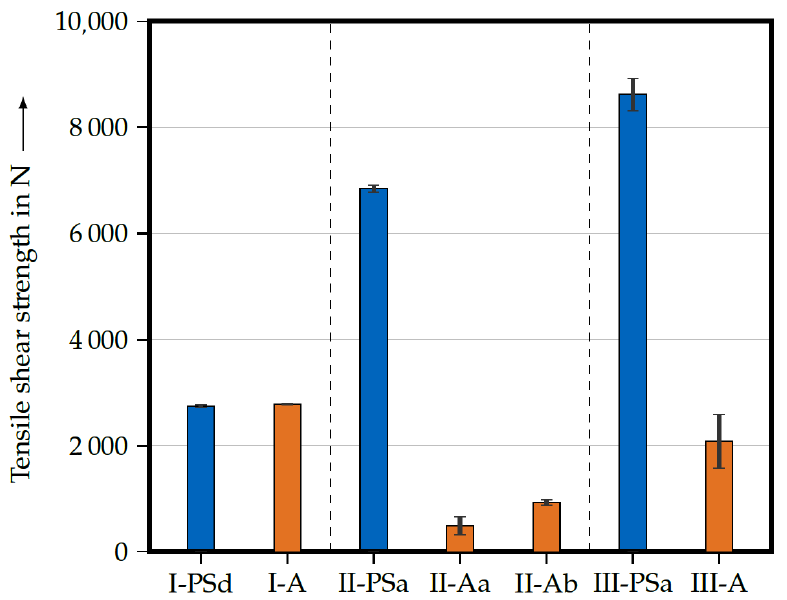
Figure 4. Tensile shear strengths of selected joints (blue, FPJ; orange, adhesive bond) including the standard deviation of five tensile shear specimens.